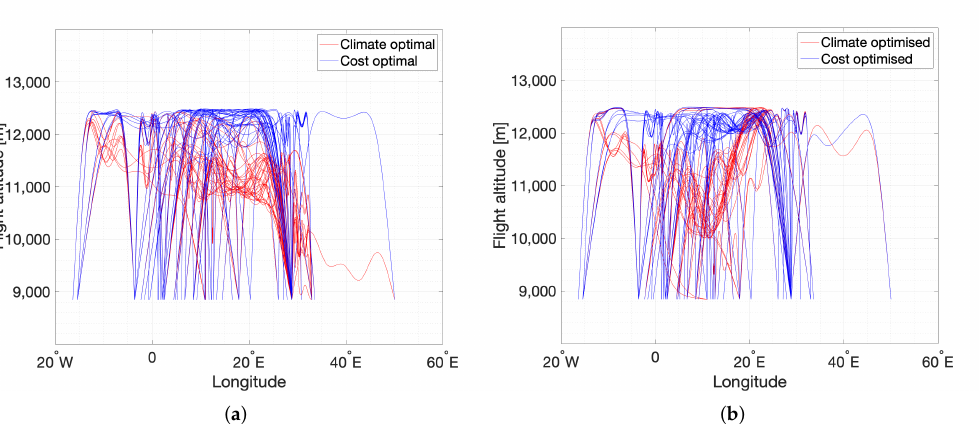
Figure 12. Vertical profile of optimised routes with respect to costs (blue) and climate (red) with a variable cruise altitude (within [FL290, FL410]) for ( a ) 1 February 2016 and ( b ) 1 August 2016. Note that lateral movements are